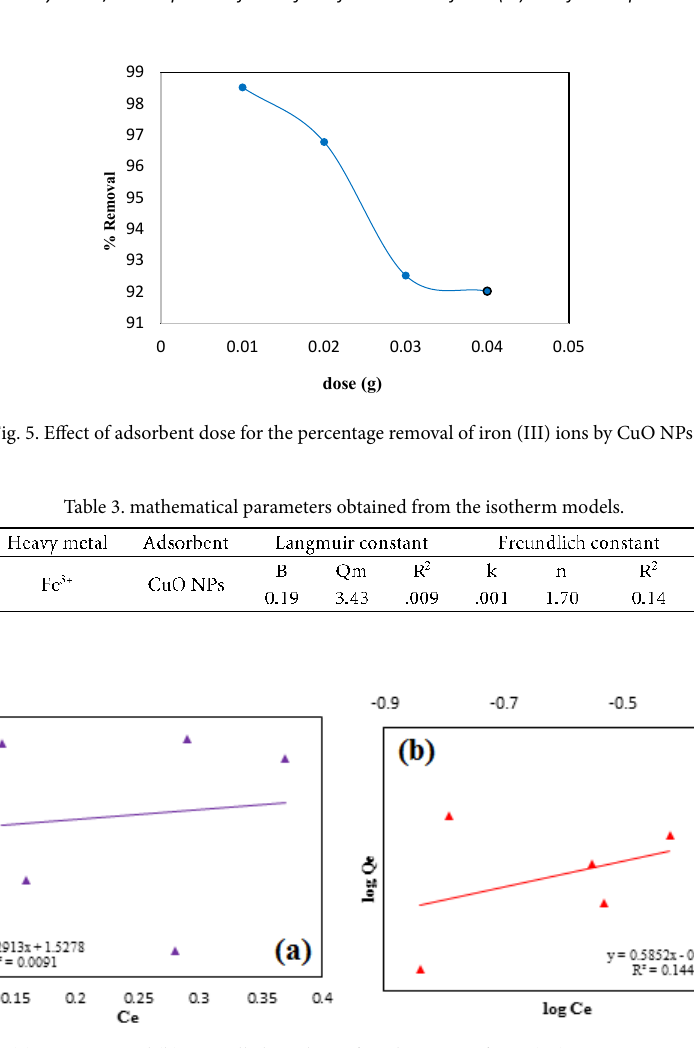
Fig. 6. (a) Langmuir and (b) Freundlich isotherm for adsorption of Iron (III) ions onto CuO